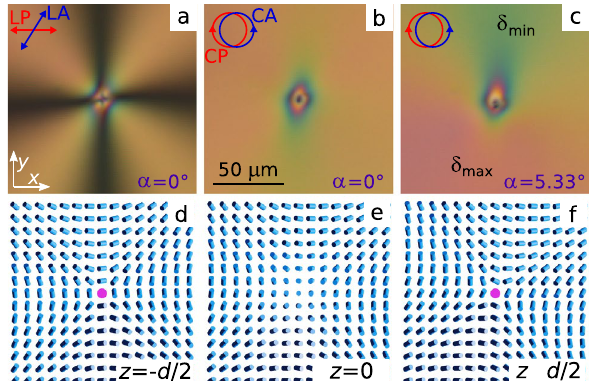
Figure 7. POM photos of chiral nematic with boojum of strength m = − 1 and the phase on the top substrate ξ d / 2 = − 116 ◦ taken in the crossed at angle 58 ◦ LP and LA at the polariser orientation 0 ◦ ( a ), in the crossed circular polarisers at the light incidence angle α = 0 ◦ ( b ) and α = 5.33 ◦ ( c ). The corresponding director field on the bottom substrate ( d ), at the layer centre ( e ) and on the top substrate ( f ) calculated by Eqs. (7) and (4).